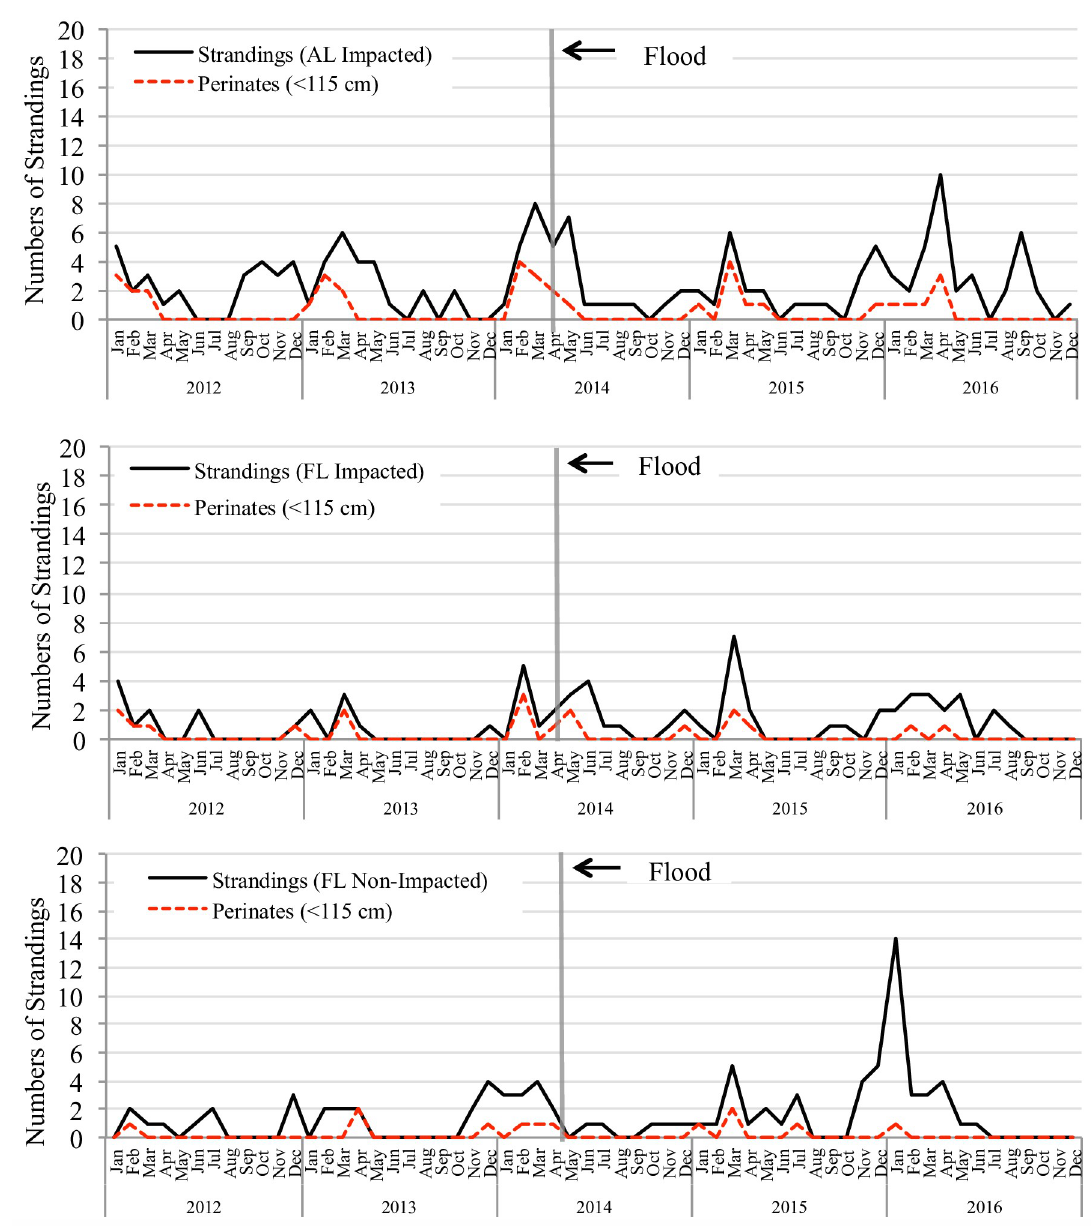
Fig 7. Total number of bottlenose dolphins ( Tt ) and Tt perinates stranded per month and year, per region, from 2012–2016. Top: Data from Alabama counties impacted by the flood (Baldwin and Mobile counties); Middle: data from the Western Florida Panhandle counties impacted by the flood (Escambia, Santa Rosa, and Okaloosa counties); Bottom: data from the Eastern Florida Panhandle counties that were not impacted by the flood (Walton, Bay, Gulf, and Franklin counties).